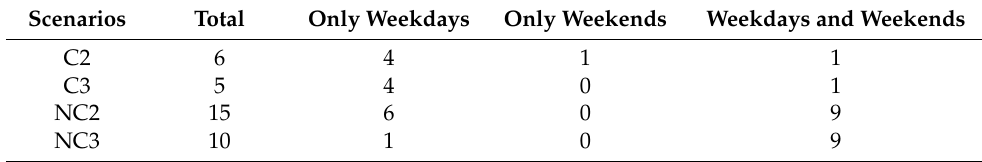
Table 1. Data sets generated from four scenarios over the seven consecutive survey days. Scenarios Total Only Weekdays Only Weekends Weekdays and